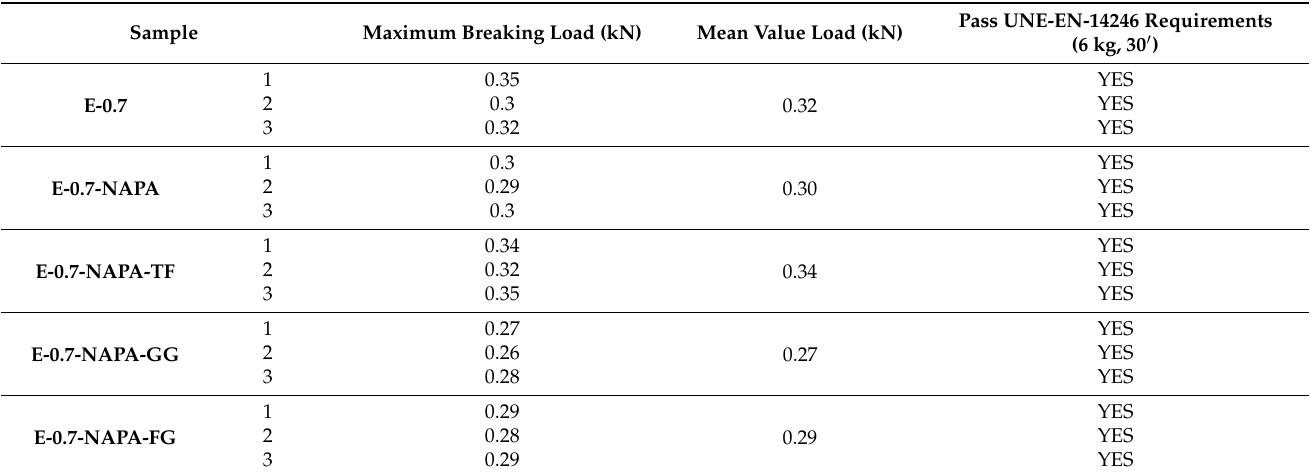
Table 5. Bending test results.